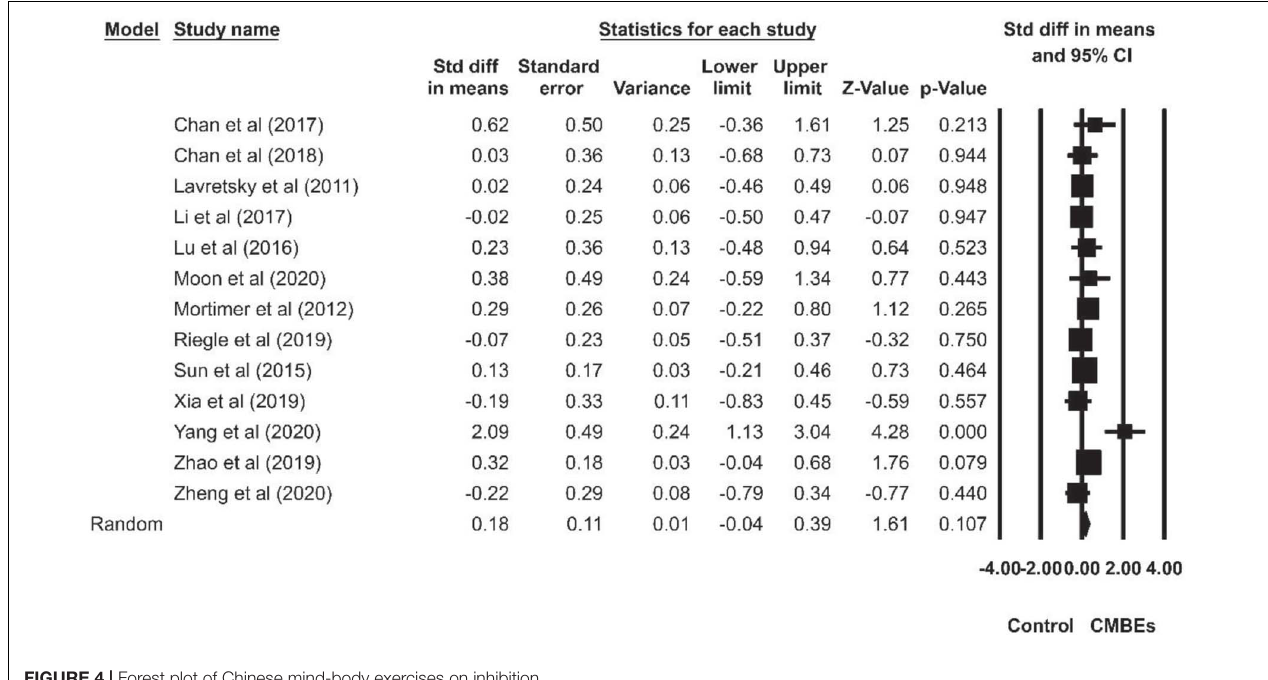
FIGURE 4 | Forest plot of Chinese mind-body exercises on inhibition.